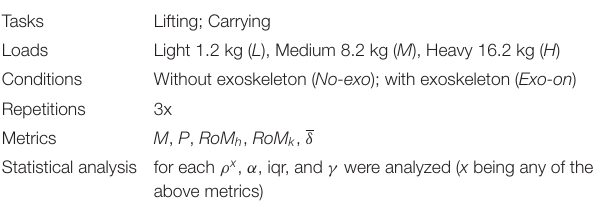
TABLE 1 | Overview of the testing protocol and the selected metrics.